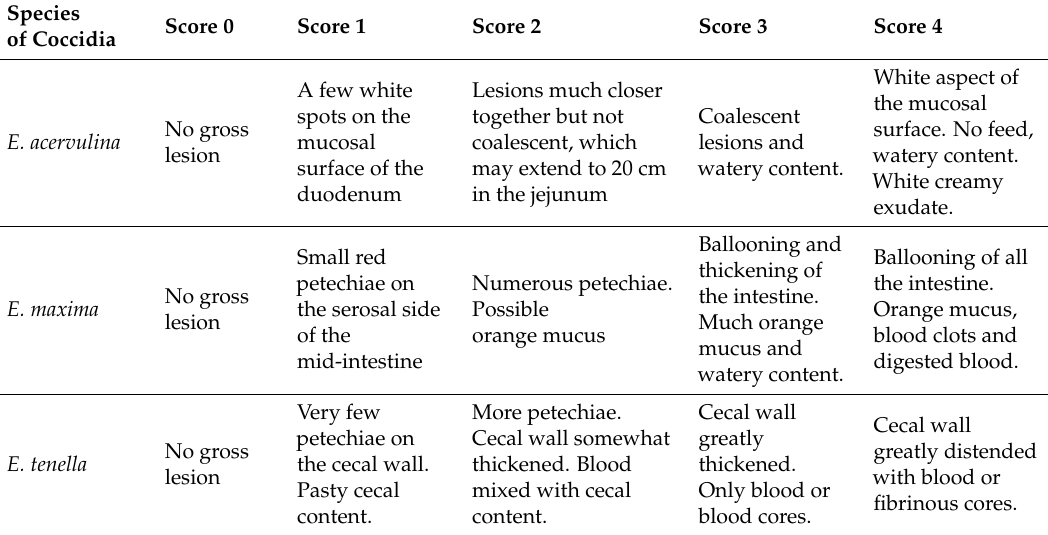
Table 2. Coccidial lesions according to the method described by Johnson and Reid